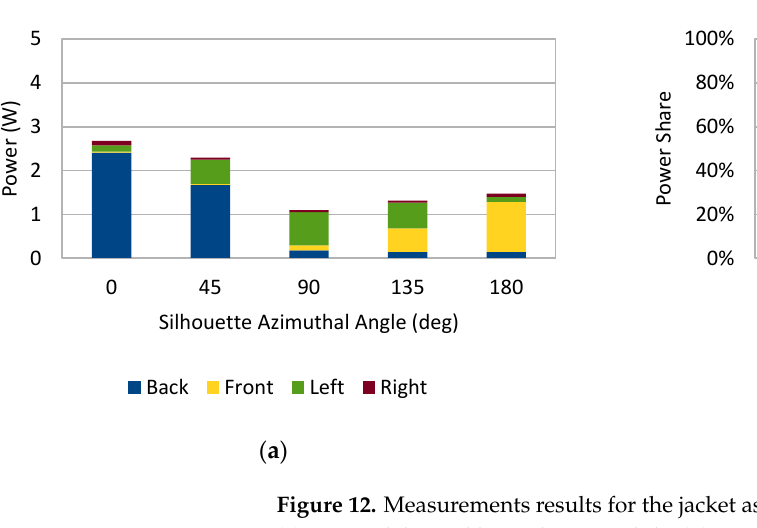
Figure 11. Measurement results for the backpack option 2 as functions of the azimuthal angle of the silhouette: ( a ) Power delivered by each PV module; ( b ) Power share of each PV module.